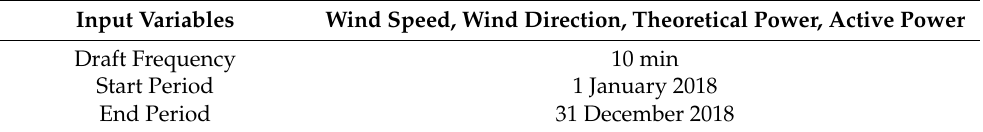
Figure 2. Functional block diagram of the proposed model. Table 1. Information for the wind turbine (Yalova wind farm, Turkey).